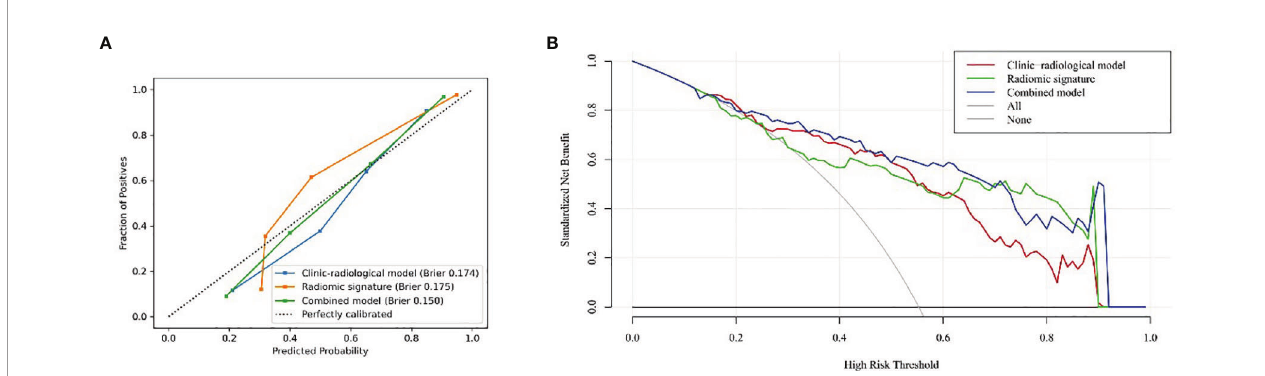
FIGURE 4 | Calibration curve of testing cohort (A) and DCA curves (B) .